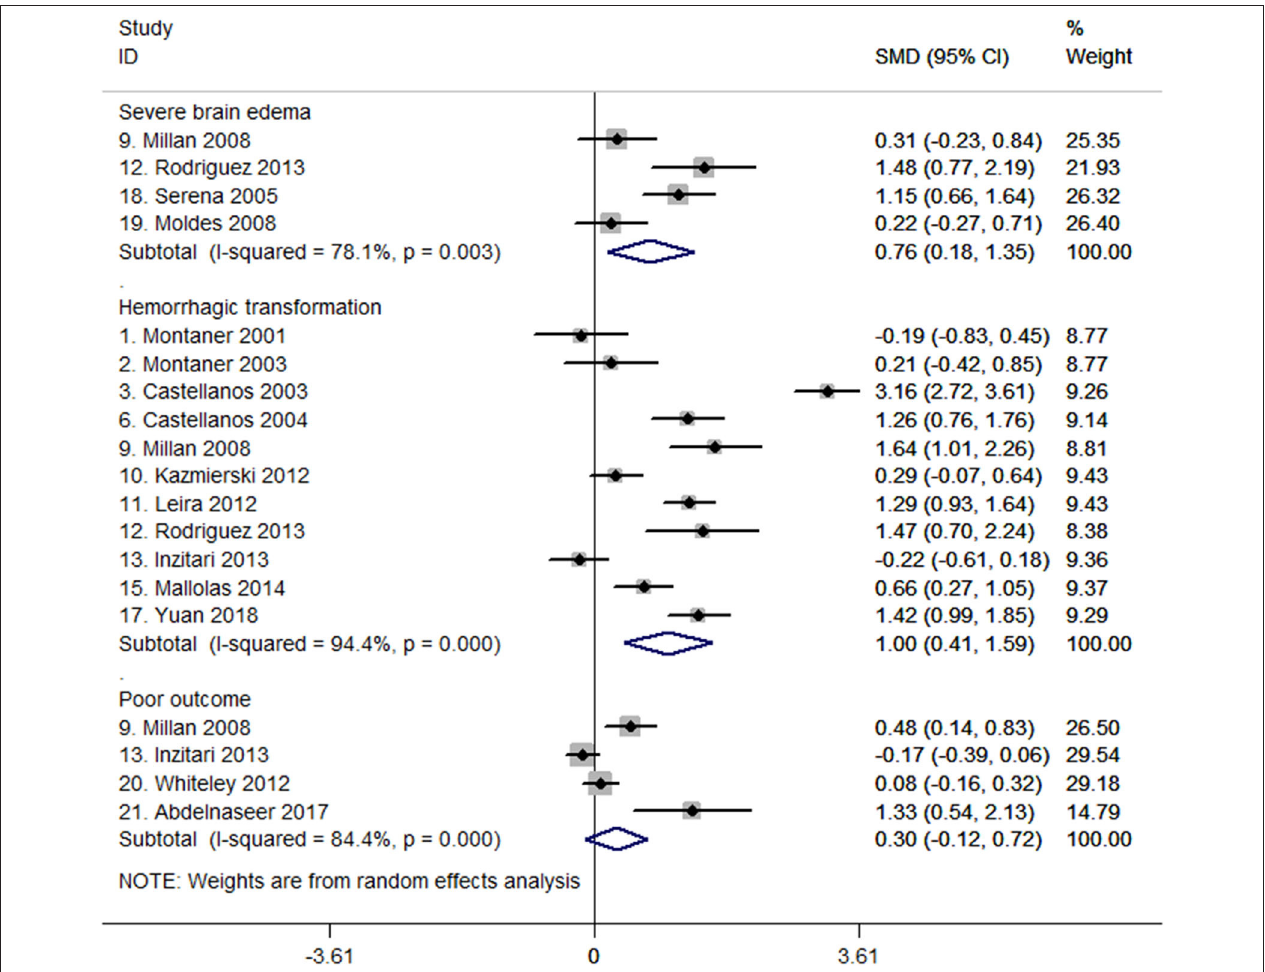
FIGURE 2 | Forest plots of standardized mean difference (SMD) in matrix metalloproteinase-9 (MMP-9) levels between different patient